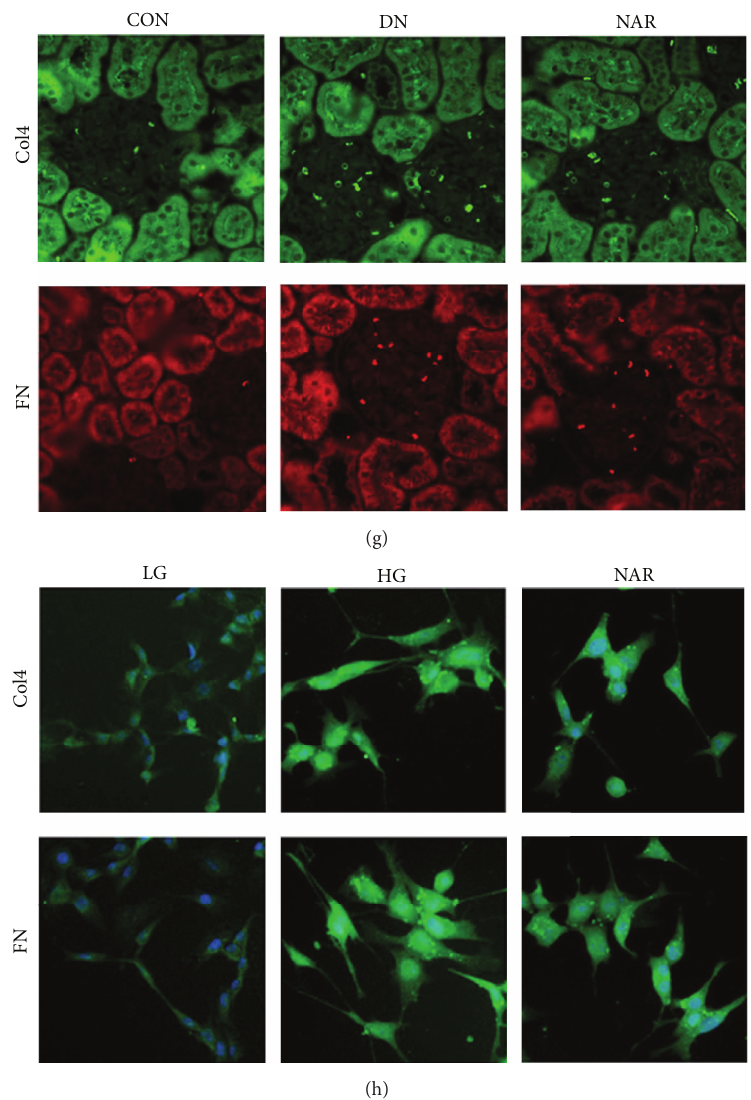
Figure 2: Effects of NAR on cell proliferation, cell cycle, and deposition of ECM proteins. (a) MTT analyses of cell proliferation rates. (b) Quantifications of the phases of the cell cycle analysis by flow cytometry. (c) Real-time RT PCR analyses of Col4 and FN mRNAs from kidney tissues. (d) Western blot analysis of Col4 and FN proteins in kidney tissues and MMCs. (e) Quantifications of the western blot bands of Col4 and FN expressions in DN rats. (f) Quantifications of the western blot bands of Col4 and FN expressions in MMCs. (g) Immunofluorescence of Col4 and FN proteins in kidney tissues of rats. (h) Immunofluorescence of Col4 and FN proteins in MMCs. (a, b) Results are expressed as mean ± standard deviation ( 𝑛 = 3 per group). ∗ 𝑝 < 0.05 ; ∗∗ 𝑝 < 0.01 versus HG group. (c) Results were normalized with GAPDH and expressed as mean ± standard deviation ( 𝑛 = 4 per group). ∗ 𝑝 < 0.05 versus CON group; # 𝑝 < 0.05 versus DN group. (e) Results were normalized with GAPDH and expressed as mean ± standard deviation ( 𝑛 = 3 per group). ∗ 𝑝 < 0.05 ; ∗∗ 𝑝 < 0.01 versus CON group; # 𝑝 < 0.05 versus DN group. (f) Results were normalized with GAPDH and expressed as mean ± standard deviation ( 𝑛 = 3 per group). ∗ 𝑝 < 0.05 ; ∗∗ 𝑝 < 0.01 versus LG group; # 𝑝 < 0.05 ; ## 𝑝 < 0.01 versus HG